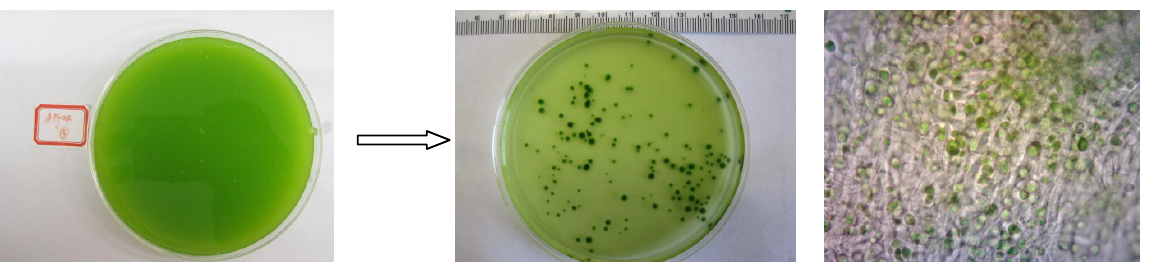
Figure 3. Pelletization of Chlorella vulguris with assistance from filamentous fungi [63,64].